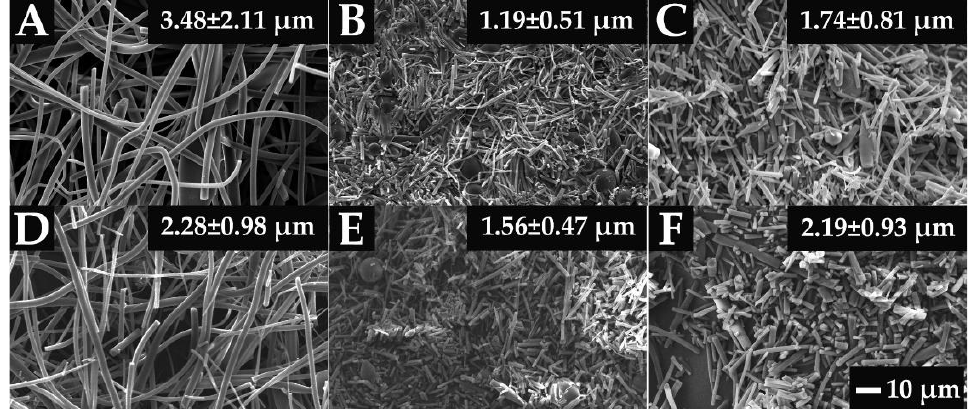
Figure 3. SEM images of the prepared electrospun samples at a magnification of 1000 ×. The average fiber diameters are indicated on the images (( A ) PVPVA64, ( B ) 10%NAP_90%PVPVA64, ( C )